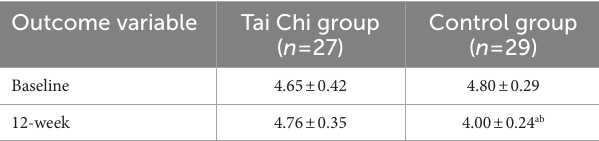
TABLE 3 Comparison of OSI at baseline and 12-week follow-up among the two groups (mean ± standard deviations). Outcome variable